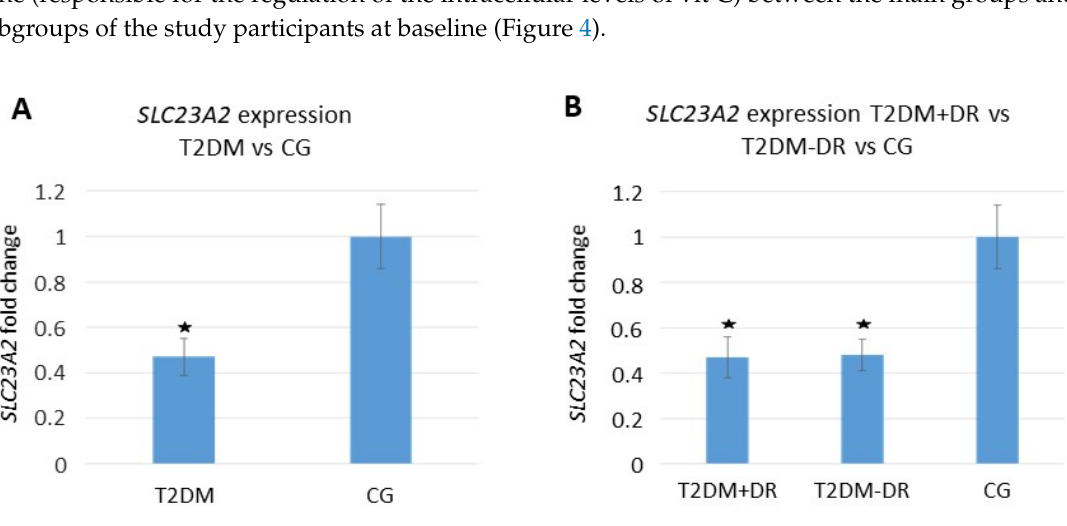
Figure 4. Plasmatic SLC23A2 relative expression at baseline. ( A ) T2DM vs. CG; ( B ) T2DM + DR vs. T2DM − DR vs. CG. (SLC23A2: Solute Carrier Family 23 Member 2 gene; T2DM: Type 2 diabetes mellitus, +/ − DR: With/without diabetic retinopathy, CG: Control group. *: p < 0.05 statistically significant).